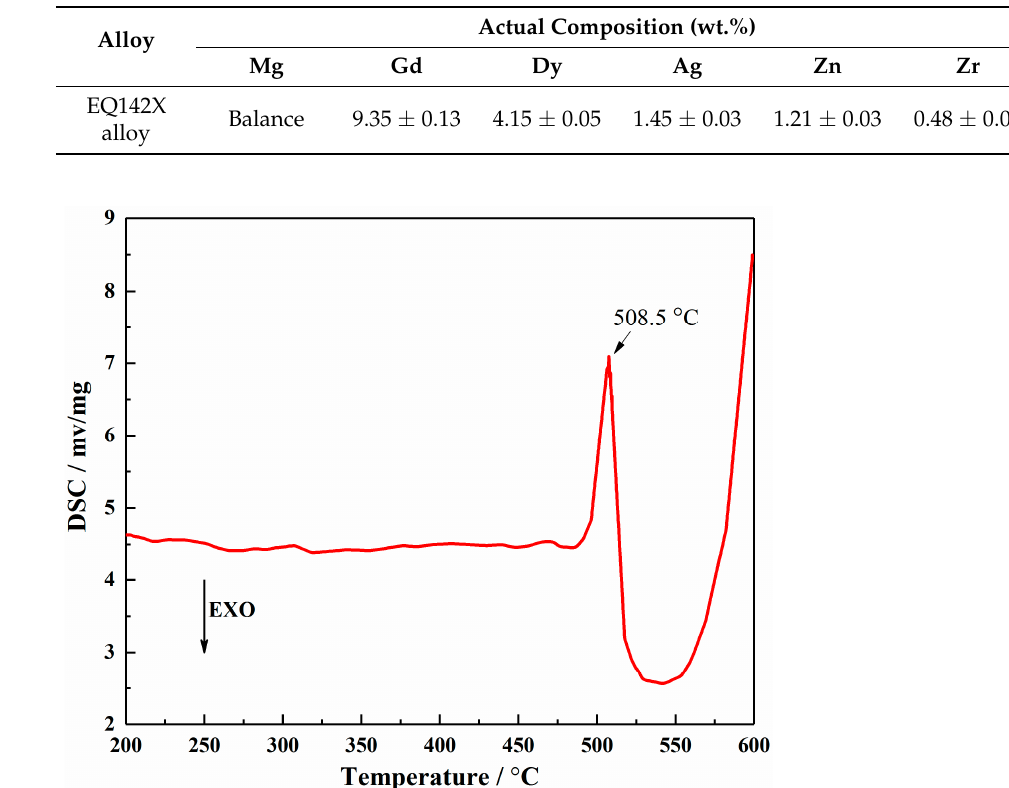
Figure 1. DSC heating curve of the as-cast EQ142X alloy. Table 2. Speci fi c processing process of the studied samples.